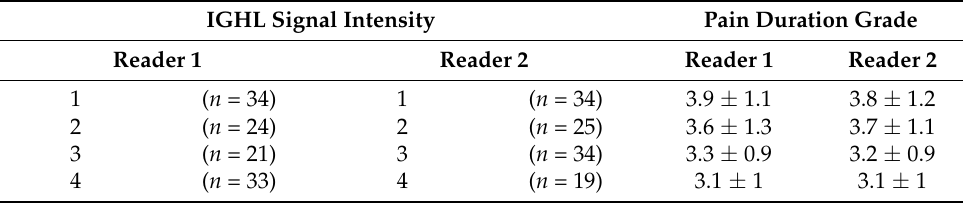
Table 3. Pain duration grade according to inferior glenohumeral ligament signal intensity grade.